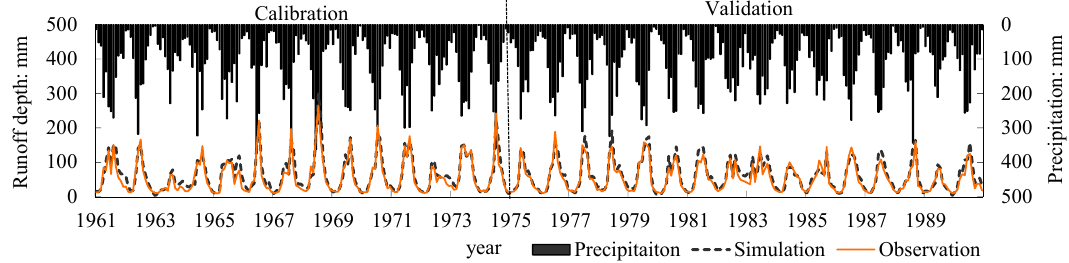
Figure 3. Monthly precipitation and observed/simulated runoff through the Gaoyao hydrological station on the Xijiang River (1961–1990).